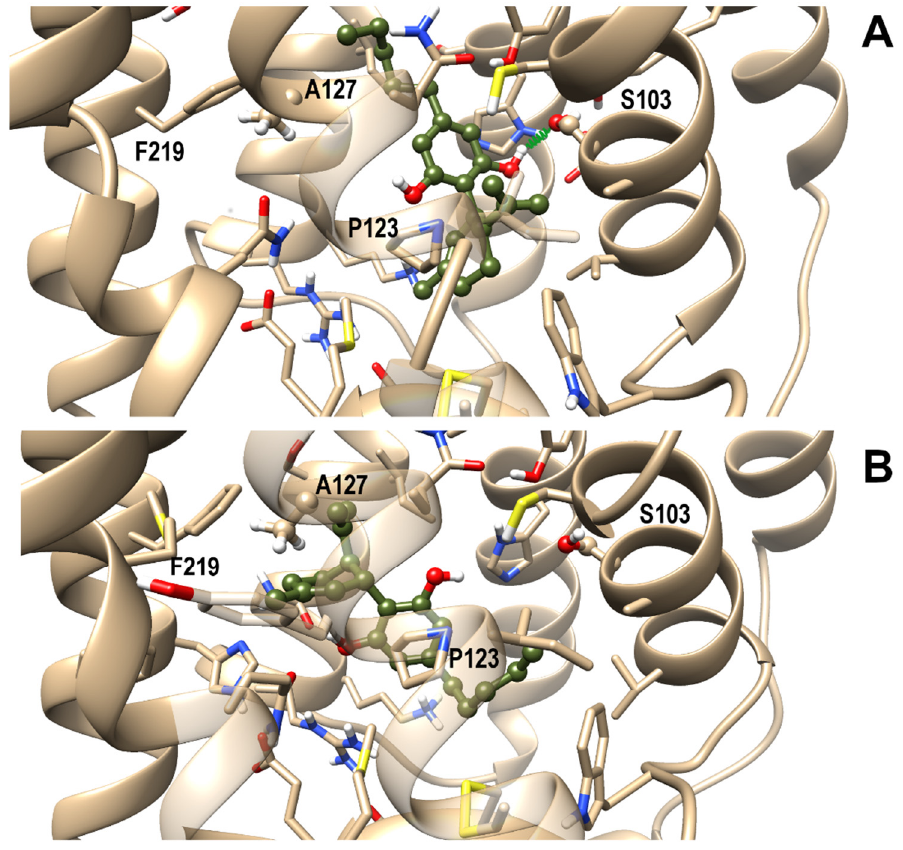
Figure 7. Representative frames from MD of CBD/OX1R complexes: Pose I ( A ) and III ( B ). A ball and stick representation (Manufacturer, City, State abbrev., if USA or Canada, Country) is used for heavy atoms plus polar hydrogens of ligand, whereas a stick representation was used for protein sidechains within 5 Å from the ligand. Protein carbon atoms are colored in tan according to ribbon for protein and olive drab for the ligand. Hydrogen, nitrogen, oxygen, and sulfur atoms are painted white, blue, red and yellow, respectively. A transparent surface for ribbons is used when- ever they hide the ligand. A “green spring” style is adopted for H-bonds involving ligand atoms. A best-fit superposition of protein backbones between CBD poses I/III and the x-ray structure of the OX1R in complex with the antagonist suvorexant (Figure 8, panels A and B, respectively) shows that, when overlapping the two ligand poses, CBD globally spans the same spatial region occupied by suvorexant, each pose filling about one-half of the volume of the bulkier suvorexant. Hence, the reduced occupancy of the binding site and the higher flexibility of CBD in comparison to suvorexant account for CBD’s lower po- tency vs. suvorexant (K i 0.55 nM) [44].